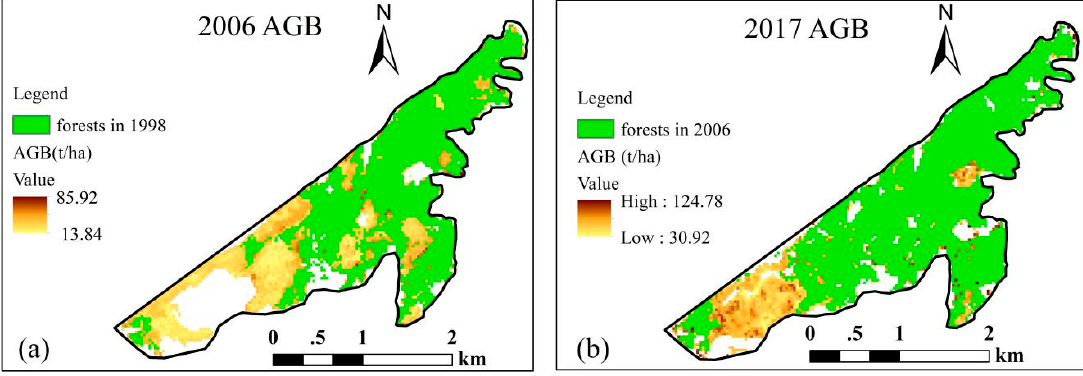
Figure 10. AGB evaluation in ( a ) 2006 and ( b ) 2017. Table 9. Quantitative analysis between landscape structure and ecological function.